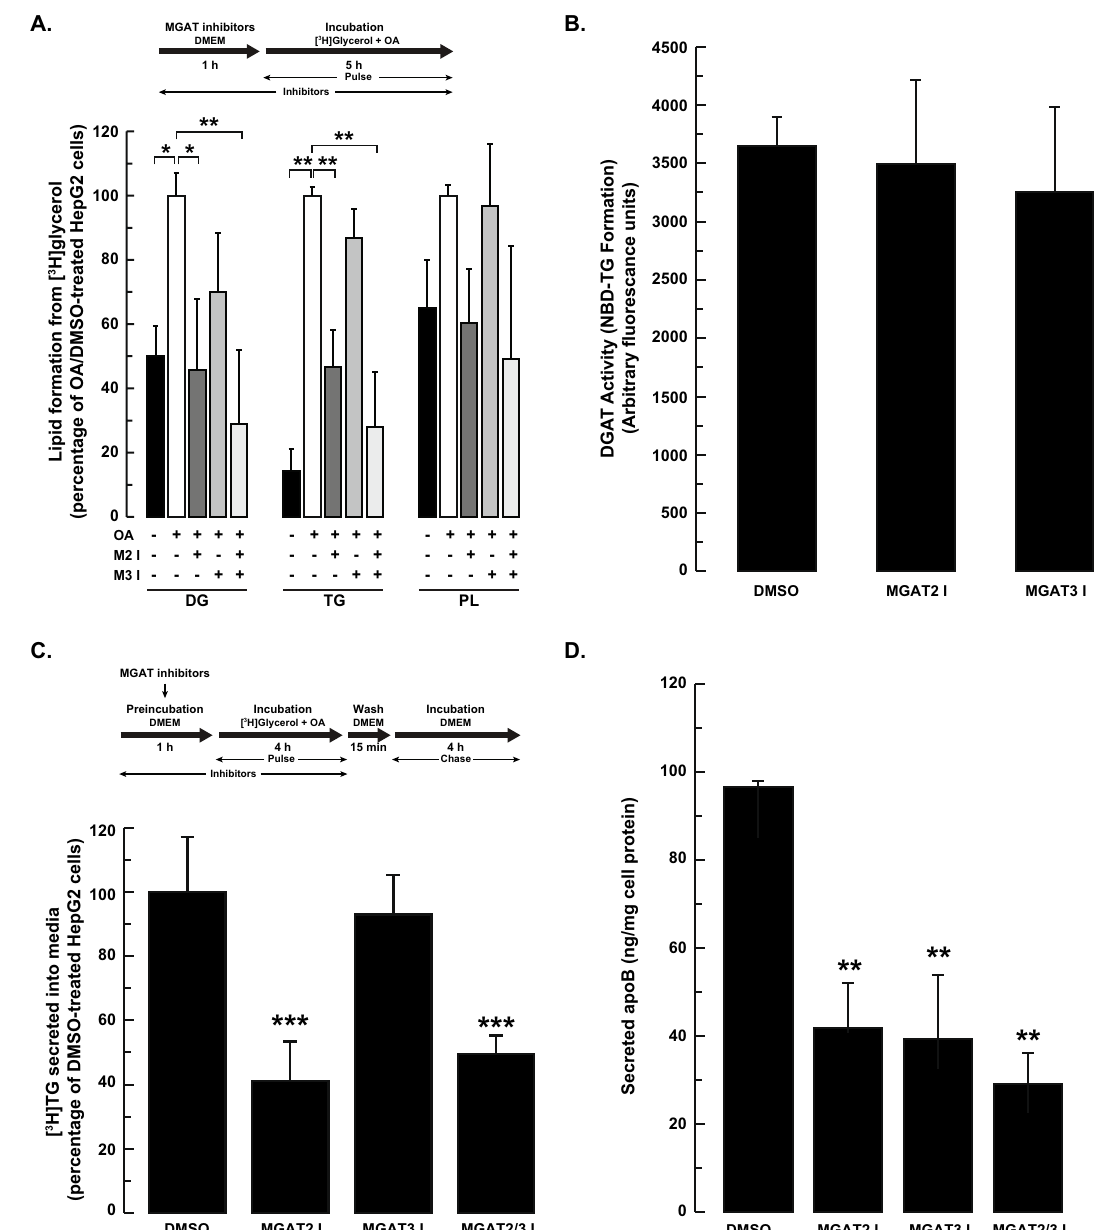
Figure 5. Inhibition of MGAT2, but not MGAT3, reduced DG and TG synthesis and TG secretion. ( A ) HepG2 cells were pre-incubated for 1 h with or without the MGAT2, MGAT3 or both inhibitors. Cells were then incubated with 5 µCi [ 3 H]glycerol and 0.25 mM OA. After 5 h, cells were harvested and the incorporation of radioactivity into TG, DG and phospholipids was determined. ( B ) HepG2 cells were incubated with the MGAT2 (25 µM) or MGAT3 (50 µM) inhibitors for 5 h. Cells were harvested and DGAT activity in crude mitochondrial fractions was determined. Data are the mean ± standard deviation of two experiments performed in duplicate. ( C ) HepG2 cells were incubated with DMEM in the presence or absence of the MGAT2 or MGAT3 inhibitors (separately and together). After 1 h, cells were incubated with 5 µCi [ 3 H]glycerol and 0.25 mM oleic acid for 4 h. Cells were then washed and incubated an additional 4 h in DMEM. The amount of [ 3 H]TG secreted into the media was determined. Data are the mean ± standard deviation of two experiments performed in duplicate. Values for DMSO-treated controls: DG (1.9 × 10 3 dpm/mg cell protein), TG (11.2 × 10 3 dpm/mg cell protein), PL (30.2 × 10 3 dpm/mg cell protein), secreted TG (0.89 × 10 3 dpm/mg cell protein). ( D ) Effect of MGAT inhibition on apoB secretion. ApoB in the culture media was quantified by ELISA after incubation of HepG2 cells with 0.25 mM OA for 6 h in the presence of the MGAT inhibitors, as described in A . Data are the mean ± standard deviation of three independent experiments. * p < 0.01; ** p < 0.001, *** p <